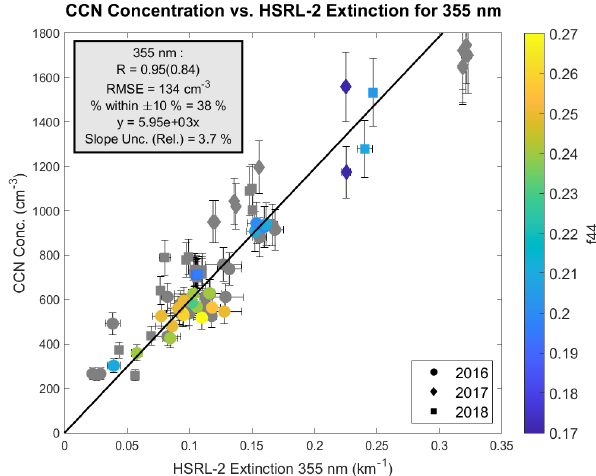
Figure 6. CCN concentration versus HSRL-2 extinction coeffi- cient at 355nm for 2016 (circles), 2017 (squares), and 2018 (dia- monds) collocated data sets. Supersaturation for these observations ranges between 0.22%–0.4%. The scatter points are color-coded by f44 value. Data without an f44 value available are filled with gray due to missing data. The f44 values range from 0.2–0.27 for 2016, 0.17 for 2017, and 0.19–0.21 for 2018. Error bars are given for a CCN relative uncertainty of 10% and for calculated HSRL-2 uncer- tainties. Lines of best fit are forced through the origin to represent the practicality of using linear regression equations to quantitatively obtain CCN concentrations using HSRL-2